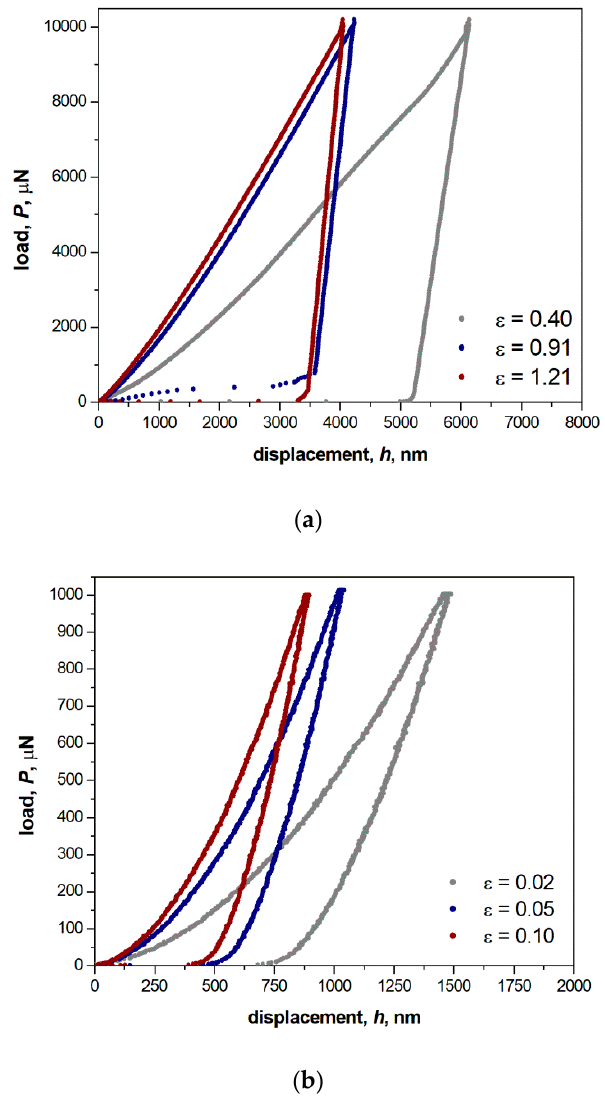
Figure 4. Nanoindentation load–displacement curves, P–h , using a load P = 10 mN, for HPT OFHC 99.99% purity Cu at ε eq = 0.40, 0.91, and 1.21 ( a ) and for 6N-Al at ε eq = 0.02, 0.05, and 0.10 ( b ).